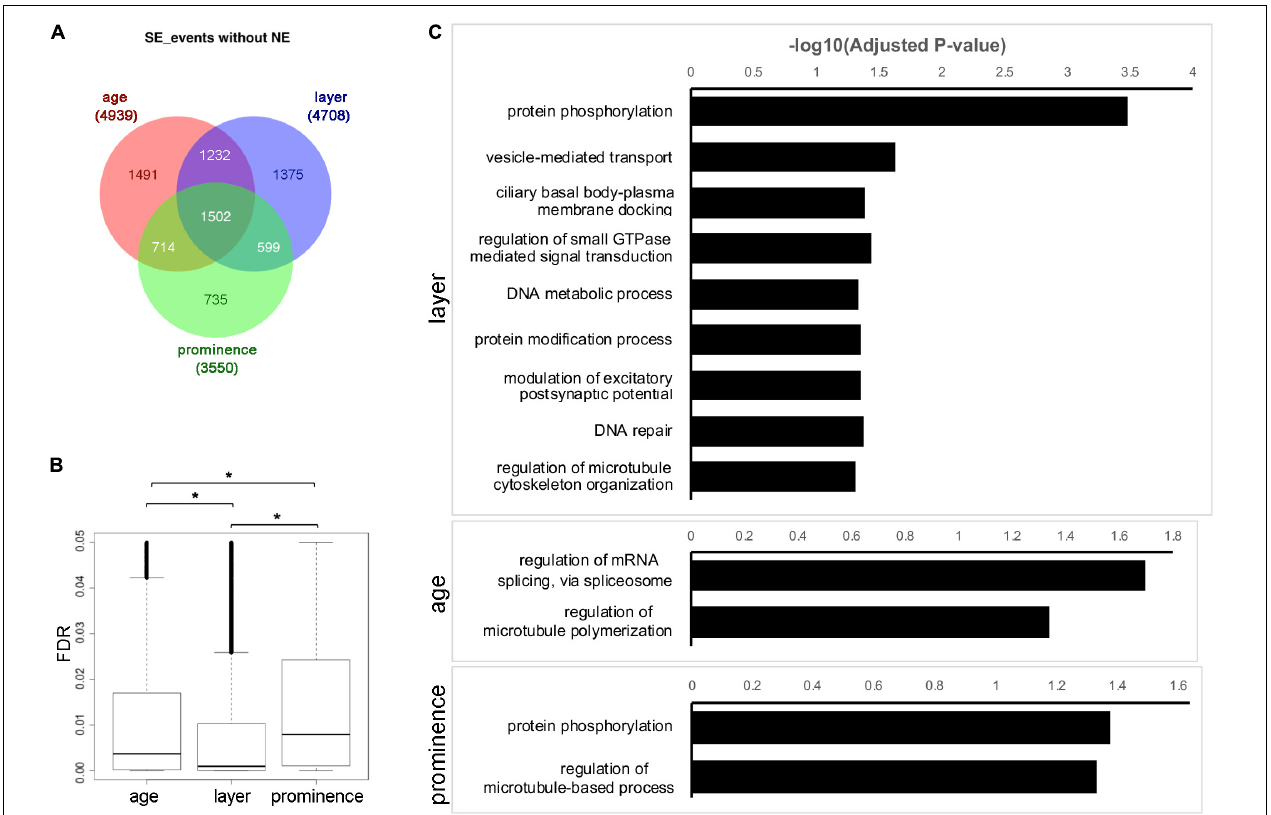
FIGURE 3 | Skipped exon usage during facial development. (A) Venn diagram showing the differentially used SE events called across age, layer, and prominence comparisons, but omitting the nasal epithelium (NE) samples. The numbers of shared or unique SE events are marked in the corresponding area. (B) Boxplots of the FDR of differentially used SE events across age, layer, and prominence. *Significant with t -test. (C) GO Biological Process (GO_BP) term enrichment for genes associated with differentially used SE events across layer, age, and prominence with adjusted p -value < 0.05. Note that manual curation was used so that only the most significant term is shown in the bar charts for similar terms. The full list of enriched terms is available in Supplementary Table 6 .